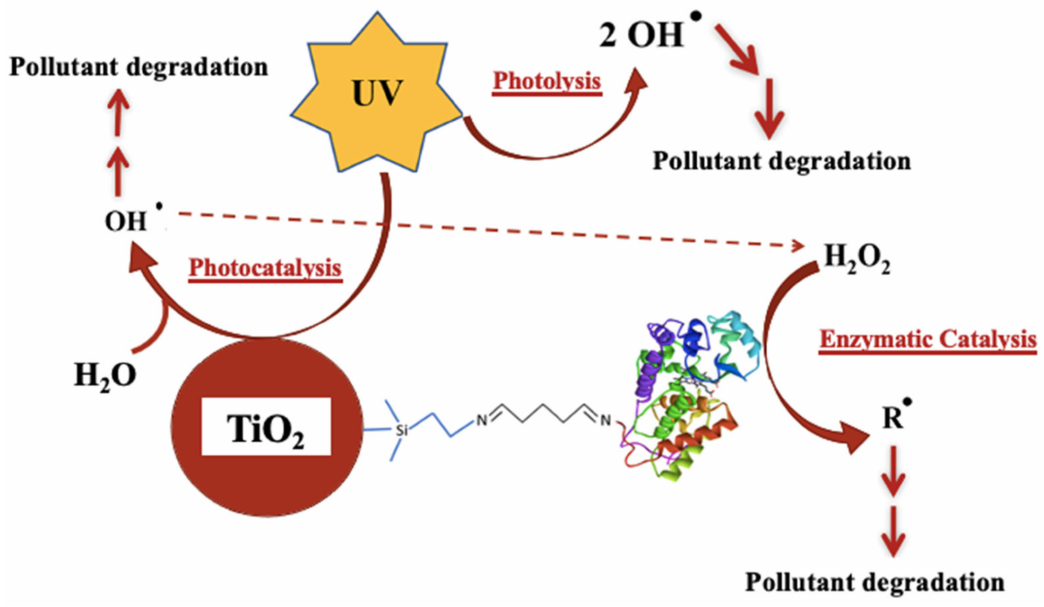
Figure 4. Schematic representation of reactions involved when a hybrid catalyst is